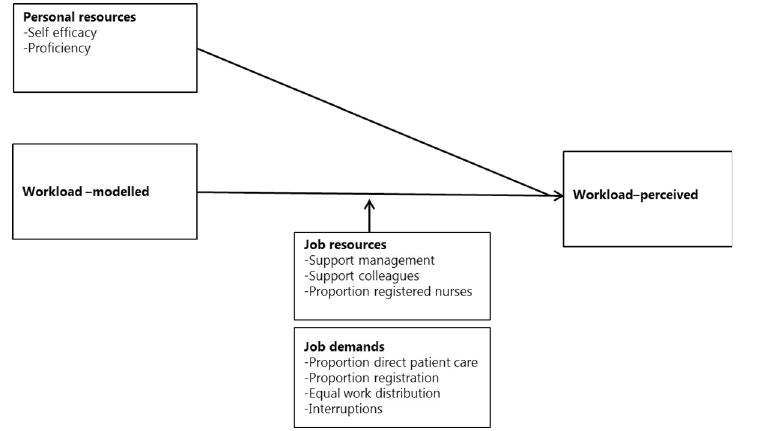
Fig 1. Studying the relation between modelled and perceived workload (our